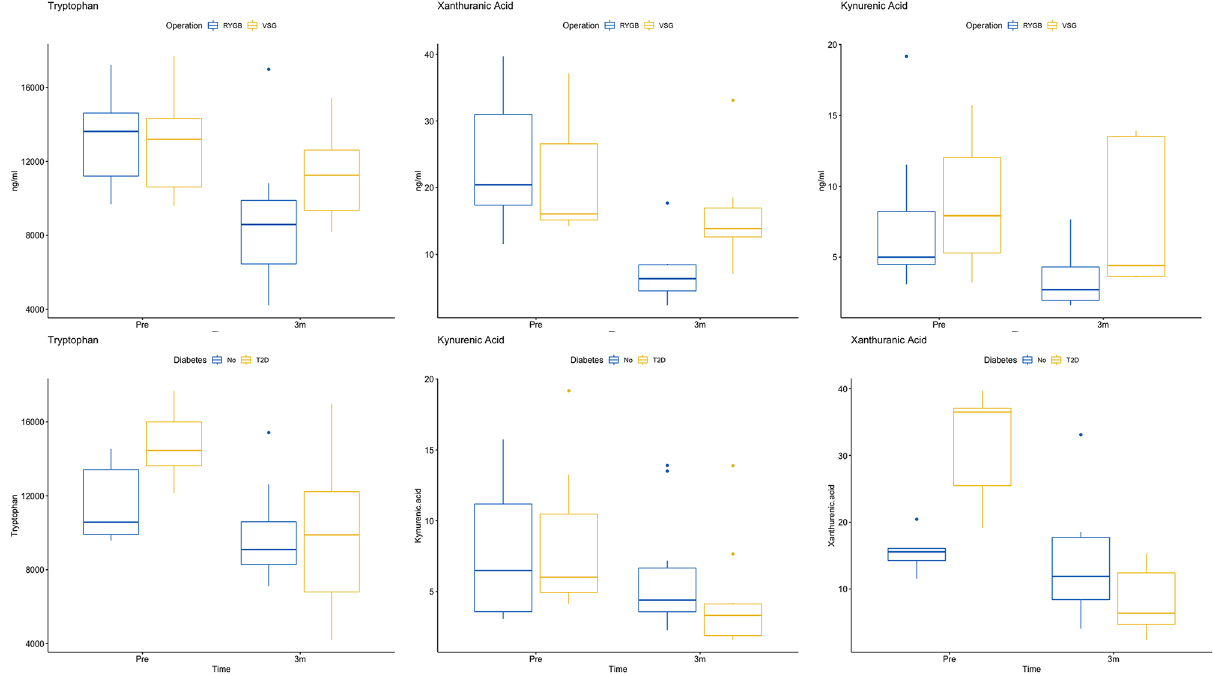
Figure 2. Pre- and post operative concentrations of tryptophan, kynurenic acid and xanthurenic acid shown with surgical procedure (top row) and T2D subgroups (bottom row).